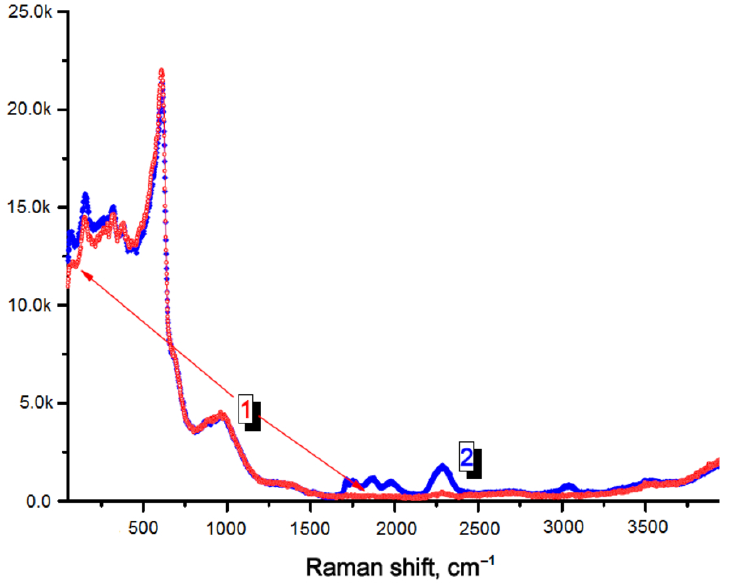
Figure 2. Raman spectra of the pristine (1, red) and HNO 3 treated (2, blue) YSZ ceramic plates. High capacity of YSZ to adsorb NO x species (NO x stands for NO and NO 2 ) was re- ported in [13,14]. It was assumed that the interaction of NO x on YSZ surface happens with the participation of oxygen vacancies in the electrolyte, which provide NO x adsorption sites. The data on temperature − programmed desorption (TPD) and diffuse reflectance in- frared Fourier transform spectroscopy (DRIFTS) reported in [14] indicate that NO x inter- action with YSZ is strong, forming different types of nitrates: bridging monodentate, che- lating, and bridging bidentate. It is reasonable to assume that the additional Raman peaks observed for the HNO 3 treated YSZ sample can be caused by these species; however, fur- ther study is needed for exact assignment of all Raman